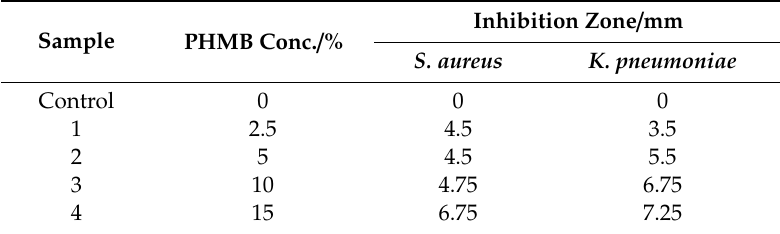
Figure 4. Qualitative assay for the antibacterial activity of PHMB-coated fabrics against S. aureus and K. pneumonia . Table 2. Effect of concentration of PHMB on antibacterial activity .